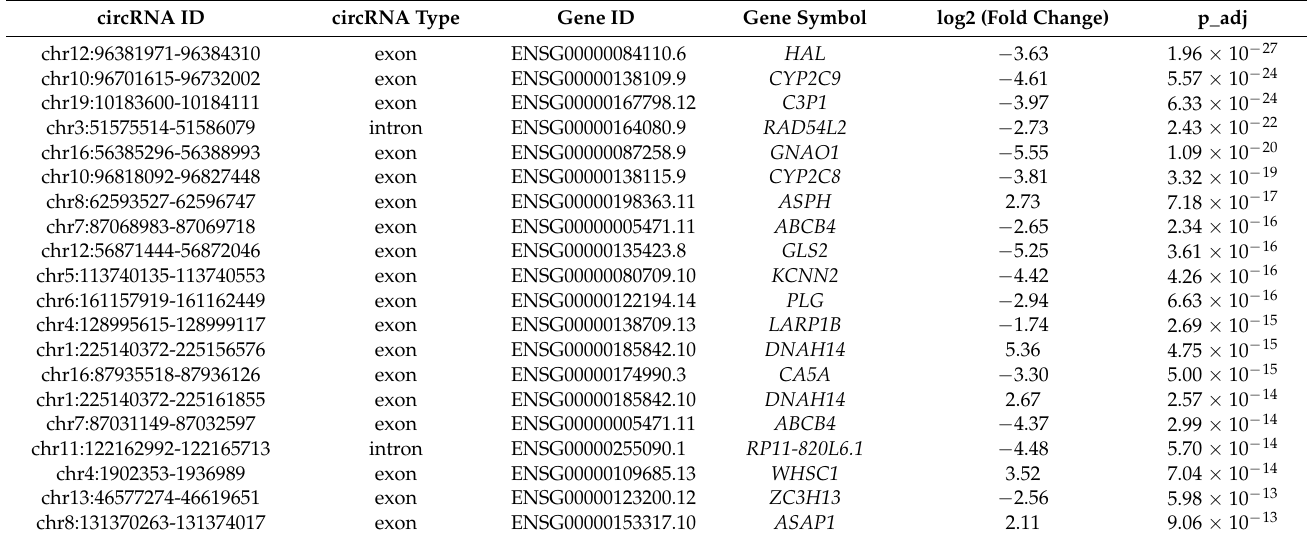
Table 2. Top 20 differentially expressed circRNAs in HCC.